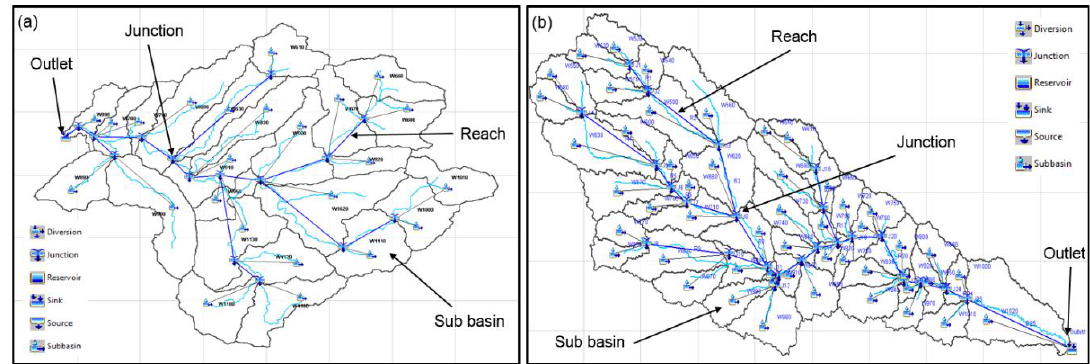
Figure 3. Sketch map of the HEC-HMS model for the Guangyuan ( a ), and Yanhe ( b )